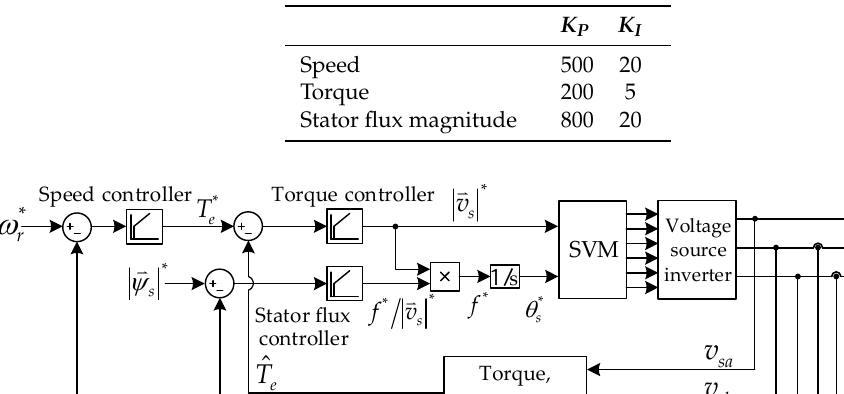
Table 2. Proportional-integral (PI) controller parameters.